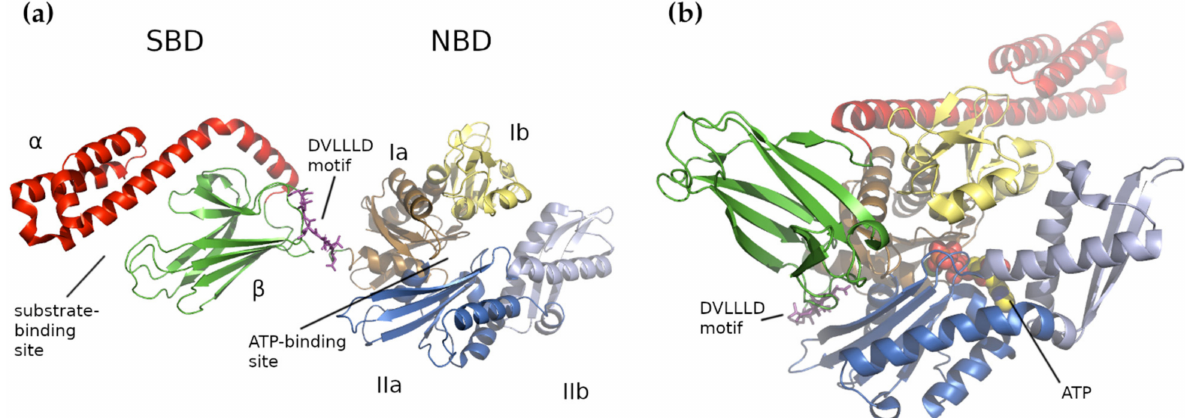
Figure 1. Structure of E. coli HSP70 DnaK. No complete structure of the human Hsp70 mortalin exists, so E. coli DnaK is used to illustrate the major structural features. ( a ) The Apo/ADP bound form with a compact substrate binding domain—closed state. The nucleotide-binding domain (NBD) is colored according to its four lobes: Ia is tan, Ib is pale yellow, IIa is marine blue and IIb is light blue. The α - and β -domains of the substrate-binding domain (SBD) are colored red and green, respectively. The substrate-binding and ATP-binding regions are indicated. The conserved DVLLLD linker is shown in magenta sticks. ( b ) The ATP-bound compact form showing an extended substrate-binding domain—open state. The bound ATP is shown as spheres and the DVLLLD motif is again indicated. Coloring is as in (a) and the orientation is roughly based on the location of the NBD in ( a ). ( a ) shows PDB structure 2KHO [108] and ( b ) is 4B9Q